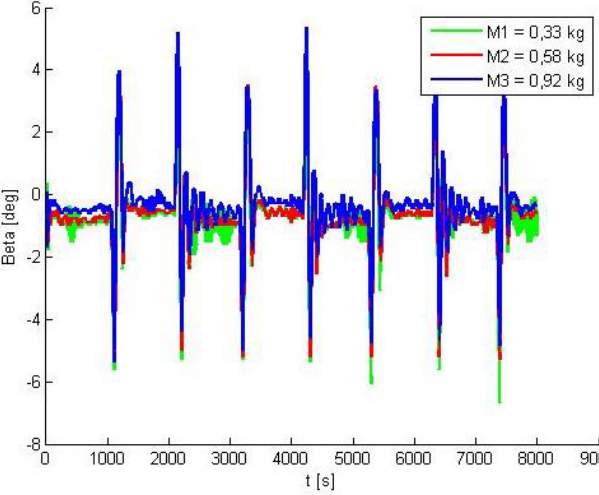
Fig. 15. Anti-swing 5DOF fuzzy logic regulator  angle of the payload oscillation simulation